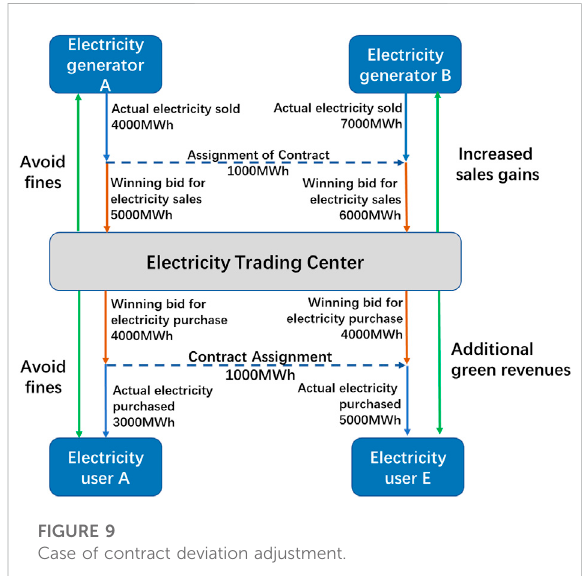
FIGURE 9 Case of contract deviation